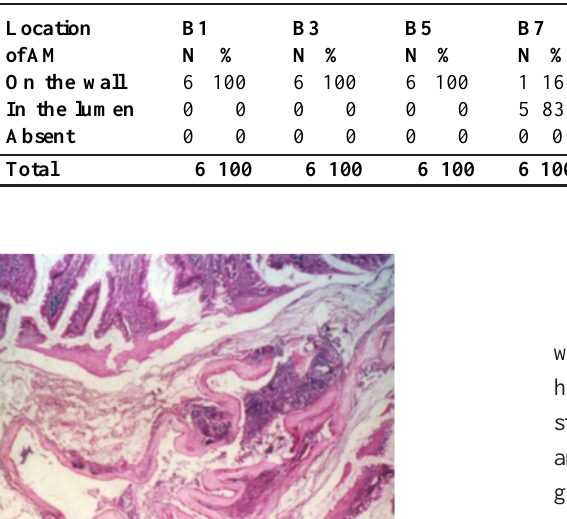
TABLE 2 - Location of the amniotic membrane patch in Group B animals